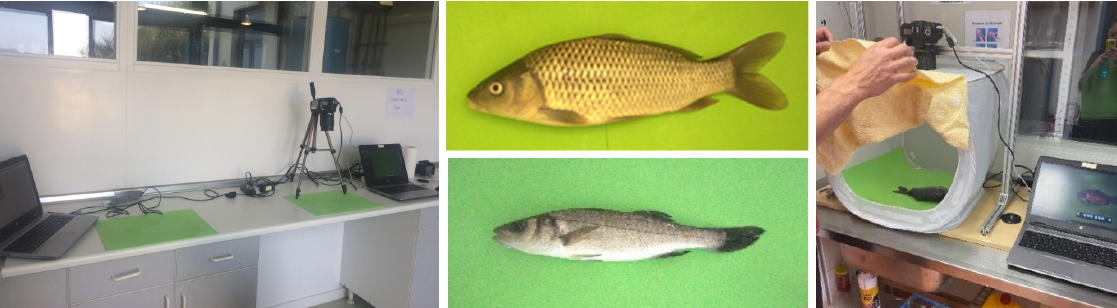
Figure 2. ( Left image ) seabass data collection design. Digital camera photographing the lateral view of the fish. Image of the seabass ( middle , bottom ) and carp ( middle , top ) on the uniform green background. This image was used for automatic fish localization. ( Right image ) experimental design for carp imaging using a tent with controlled lighting conditions.